Question: What type of chart is this?
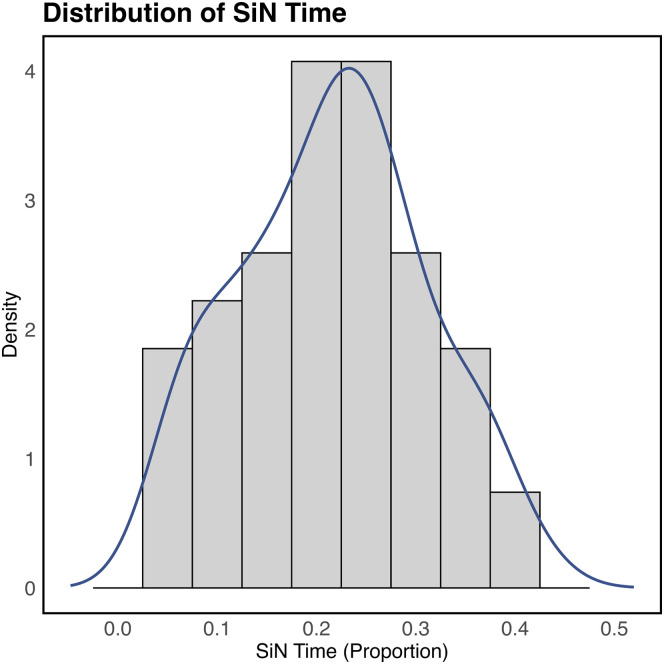
Answer: histogram